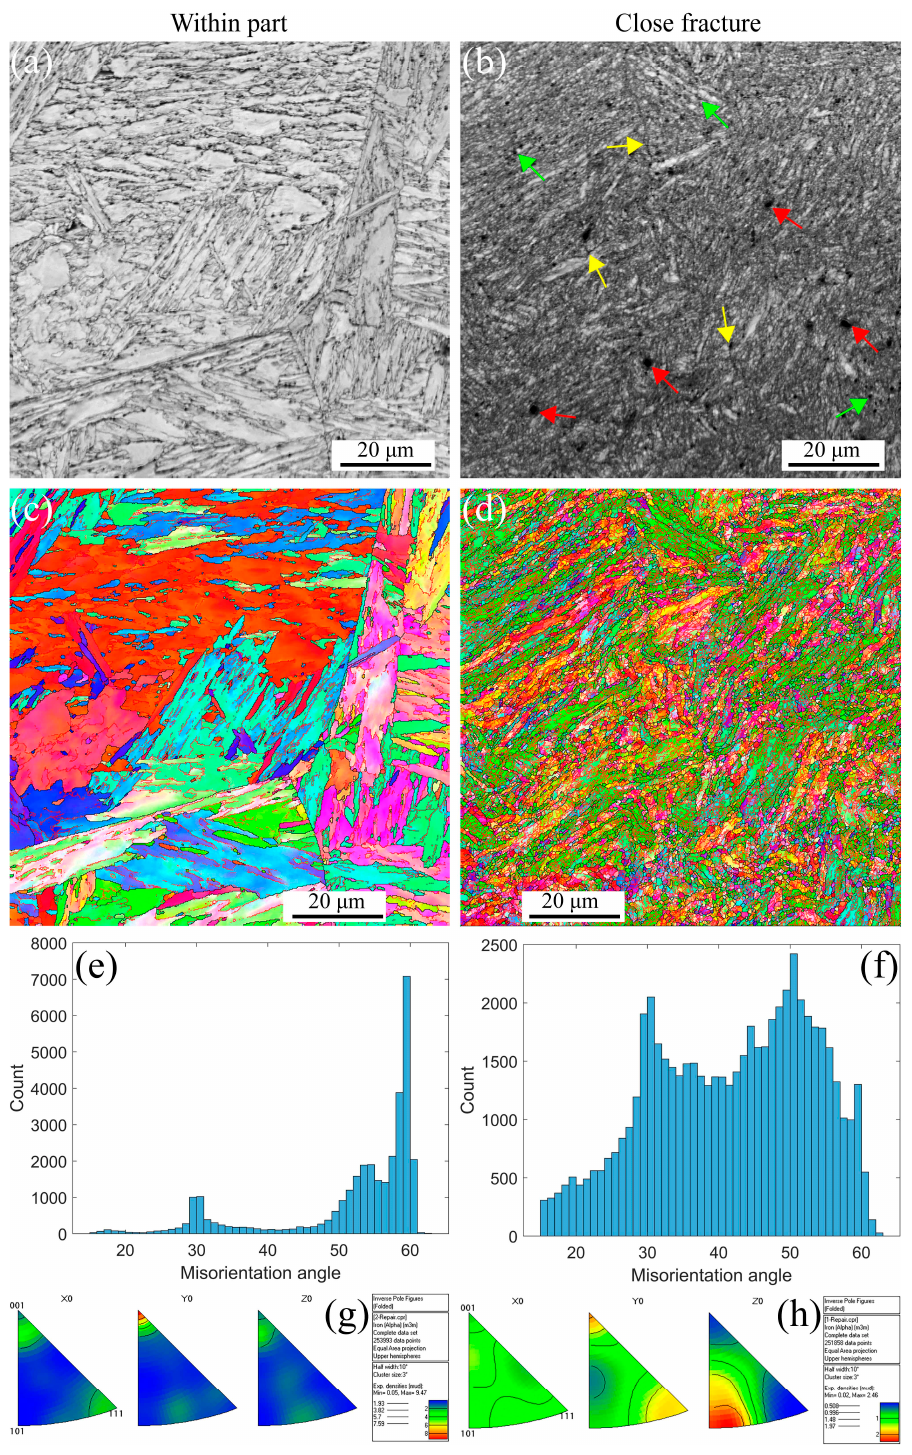
Figure 6. EBSD maps under different strain gradients at the strain rate of 5 × 10 − 3 s − 1 under 430 ◦ C (Red arrows indicate voids within the grain and along the line, green arrows indicate shrinking microstructures, and yellow arrows point to voids and shrinking cracks). ( a , b ) IQs; ( c , d ) IPFs; ( e , f ) misorientation angles; and ( g , h ) inverse polo